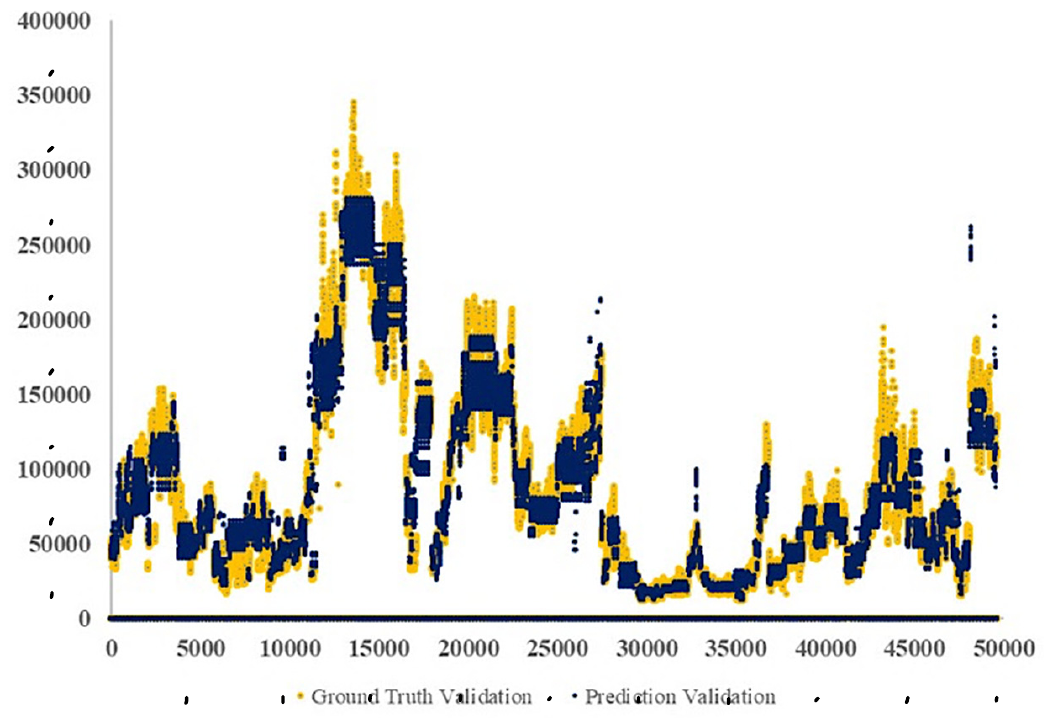
Figure 9. Ground truth prediction of values within the validation data set employing RF algo- rithm.